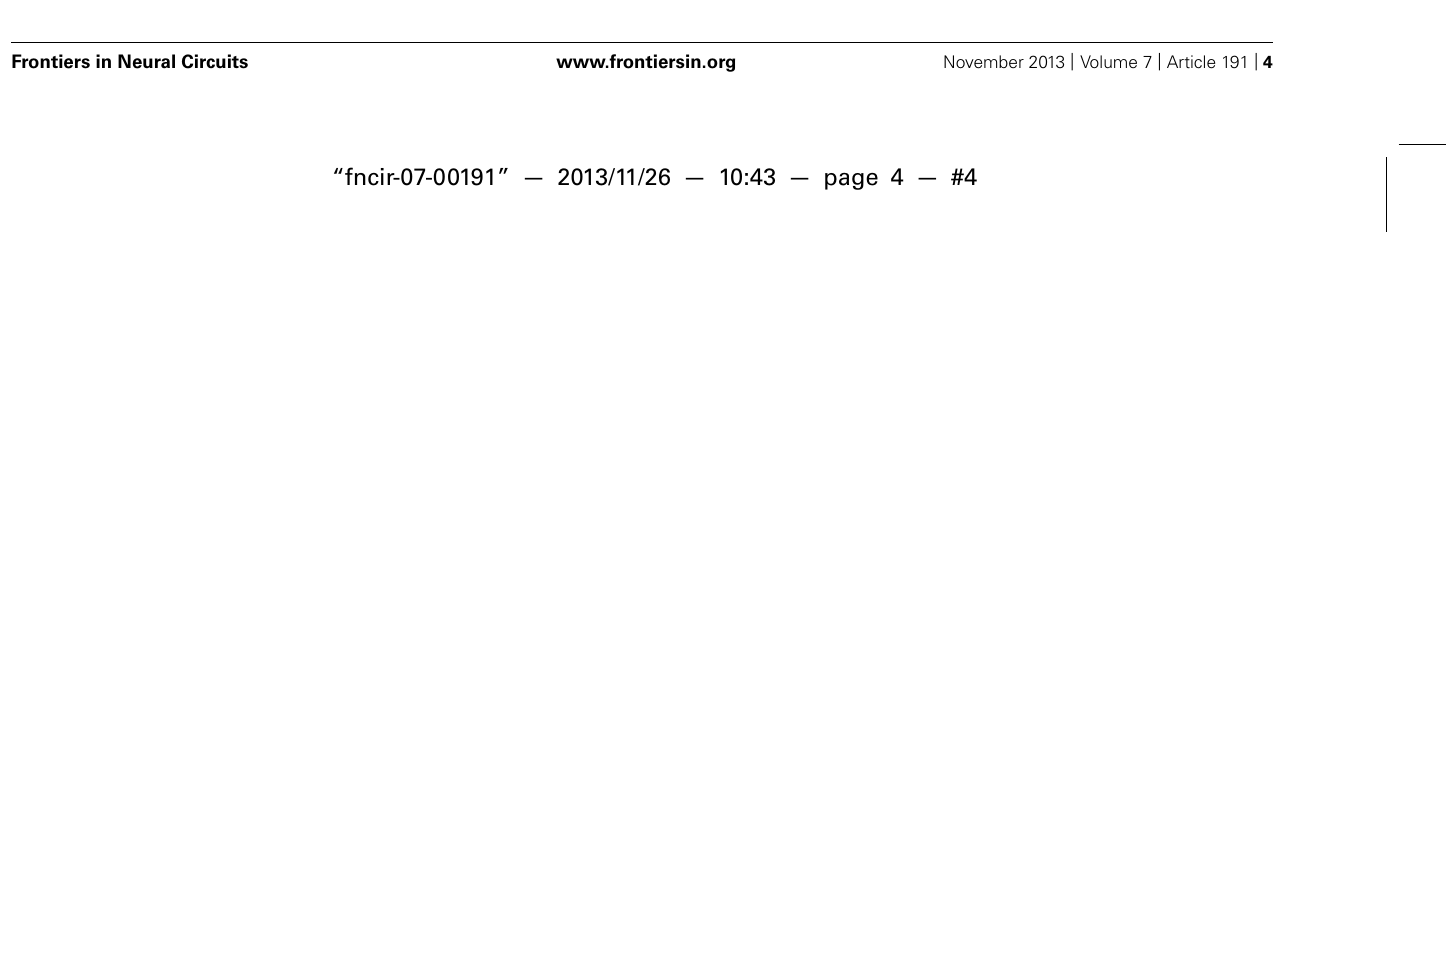
FIGURE 3 | Effects of blockers of receptors on CORT-induced changes in the thorn density. A 1 h treatment in ACSF without drugs (Control), with 1 μ M CORT (CORT), with 1 and 10 μ M RU486 (CORT + RU), with 1 μ M CORT and 20 μ M CNQX (CORT + CNQX), and with 1 μ M CORT and 50 μ M MK-801 (CORT + MK).Vertical axis is the average number of thorns per 1 μ m of dendrite. Results are reported as mean ± SEM.The significance of CORT or drug effect was examined using theTukey–Kramer post hoc multiple comparisons test when one way ANOVA tests yielded P < 0.05. * P < 0.05, ** P < 0.01 vs. Control. # P < 0.05 vs. CORT. For each drug treatment, we investigated 3 rats, 6 slices, 12 neurons, 12 dendrites, and 1400–1800